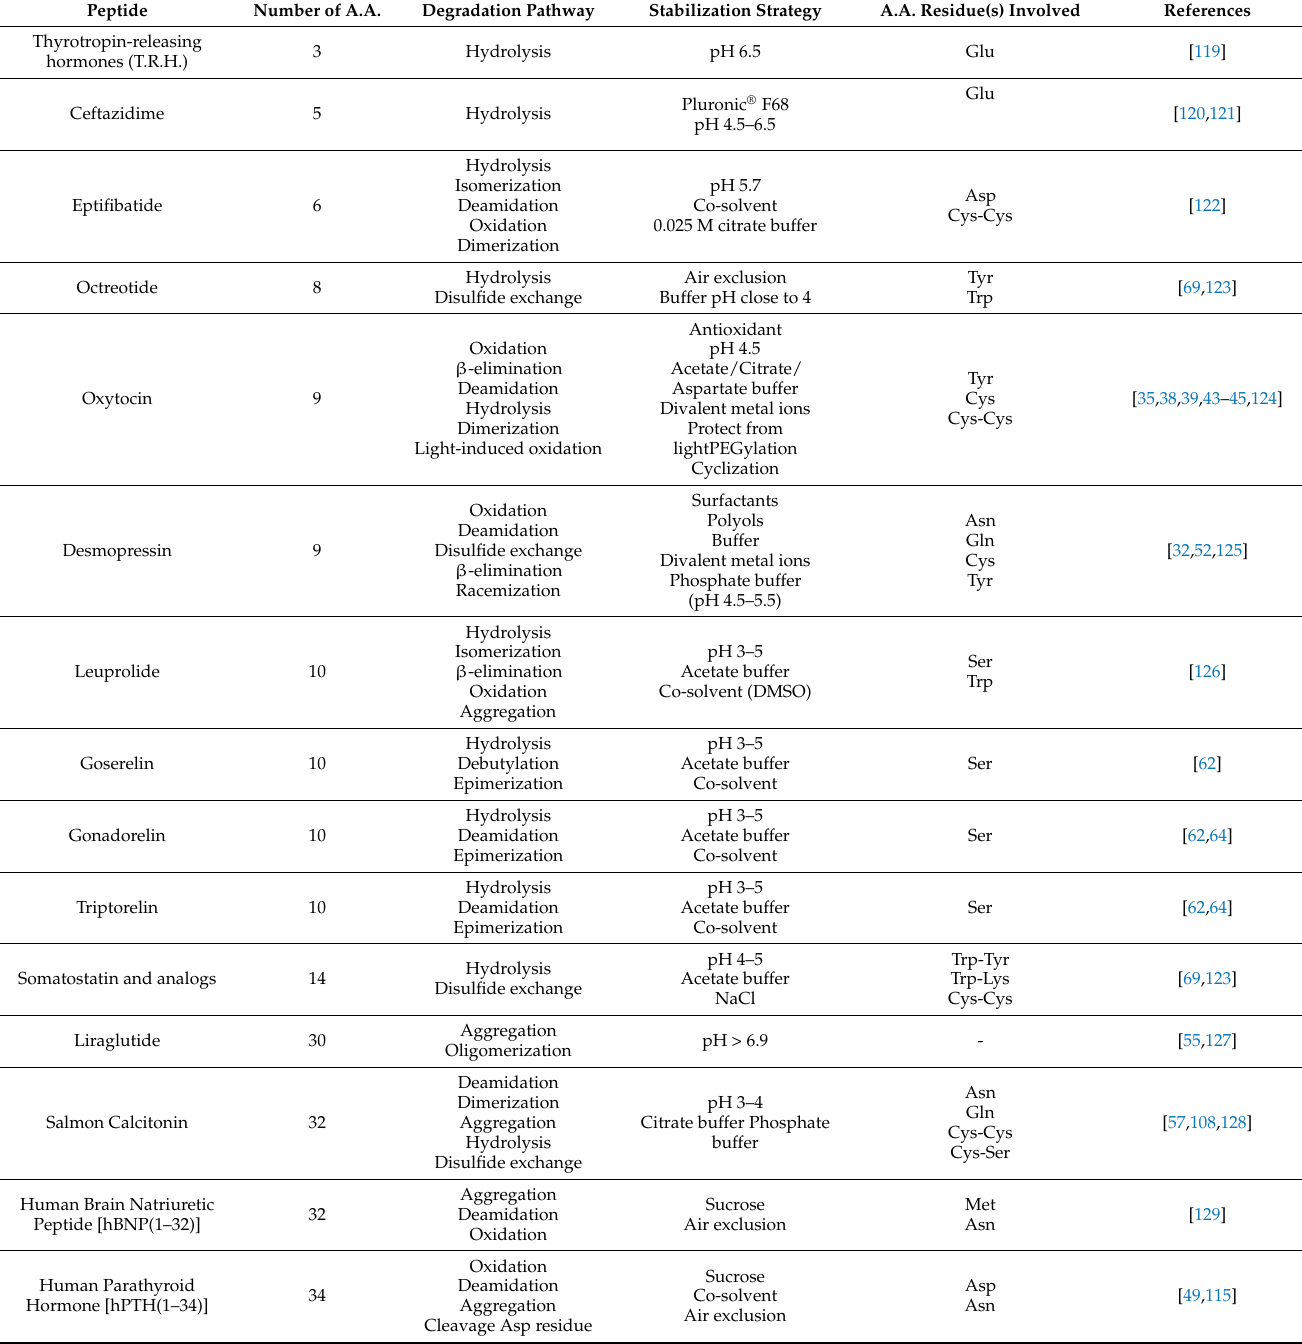
Table 4. Peptide therapeutic degradation pathways and possible stabilization